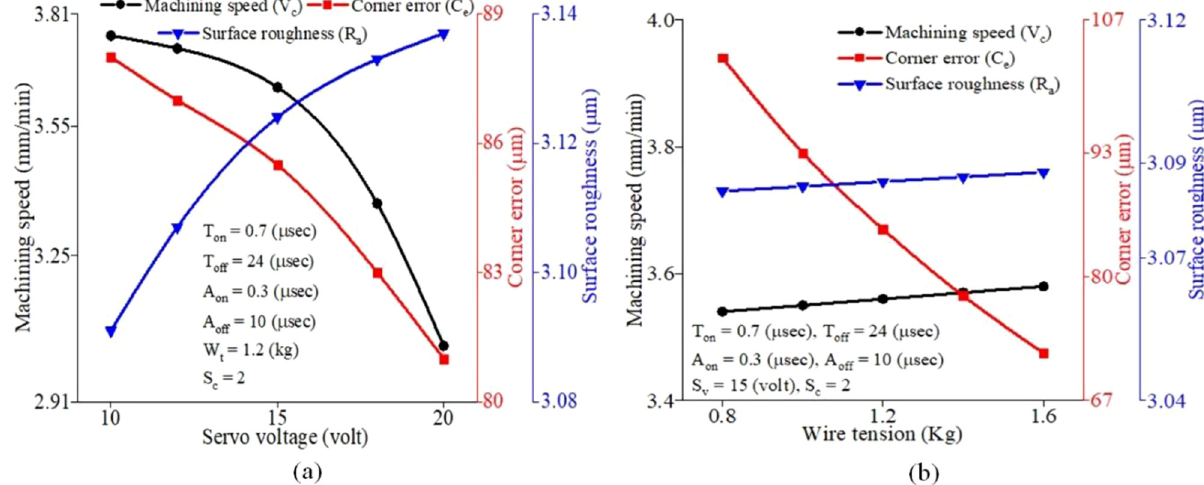
Fig. 5. Effect of (a) servo voltage and (b) wire tension on machining speed, corner error and surface